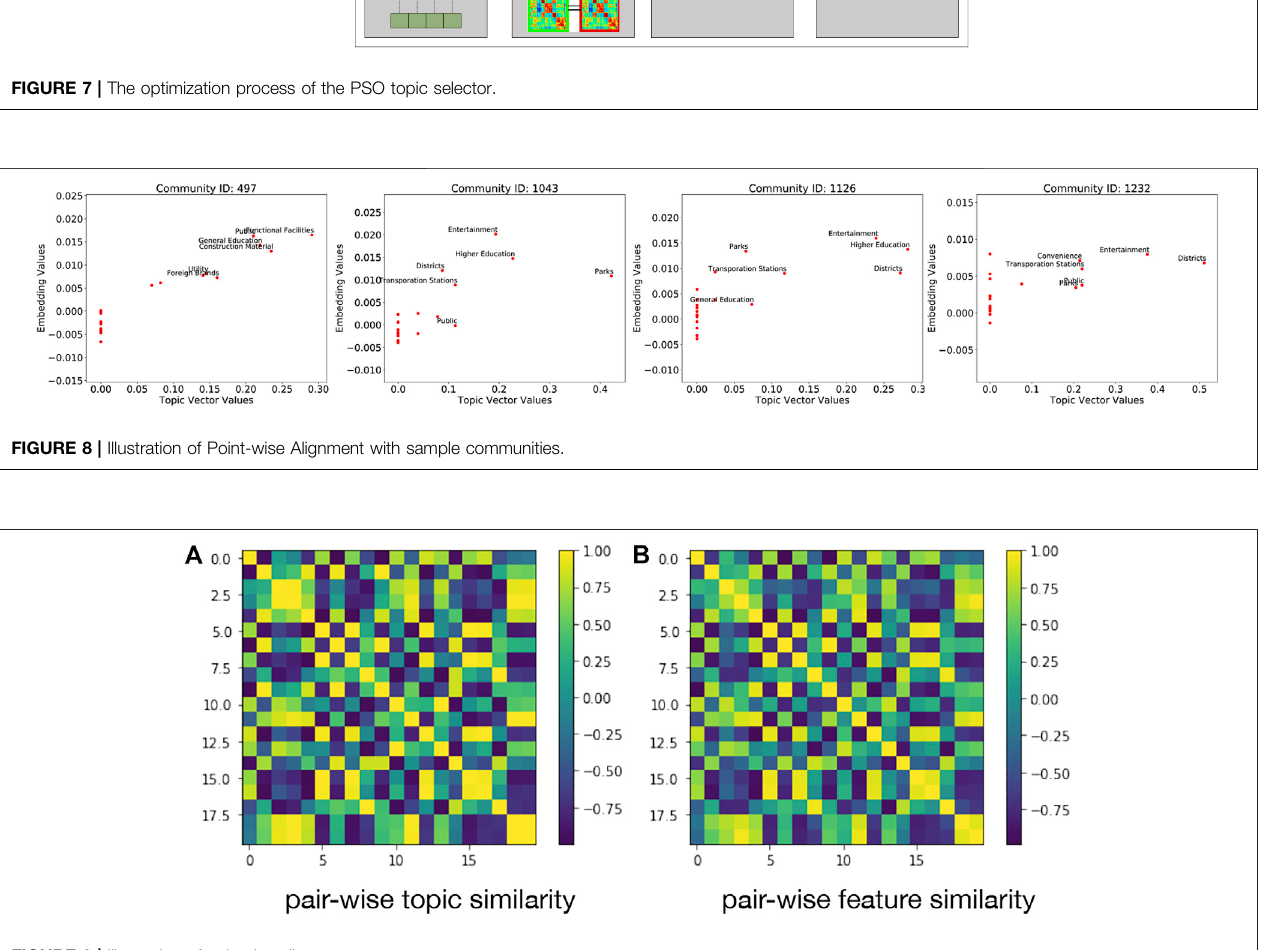
FIGURE 9 | Illustration of pair-wise